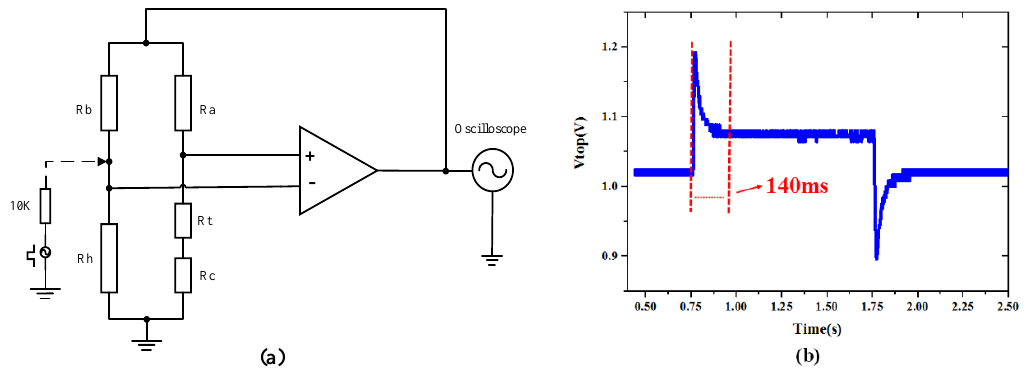
Figure 10. ( a ) Schematic conditioning circuit of sensor system; and ( b ) tested dynamic response.